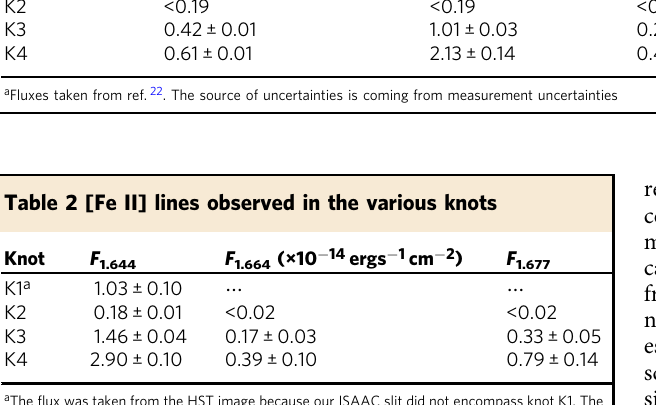
Table 1 Radio fl uxes and spectral indexes in the various knots (cid:1) (cid:3) Knot I peak mJy = beam 5 : 8